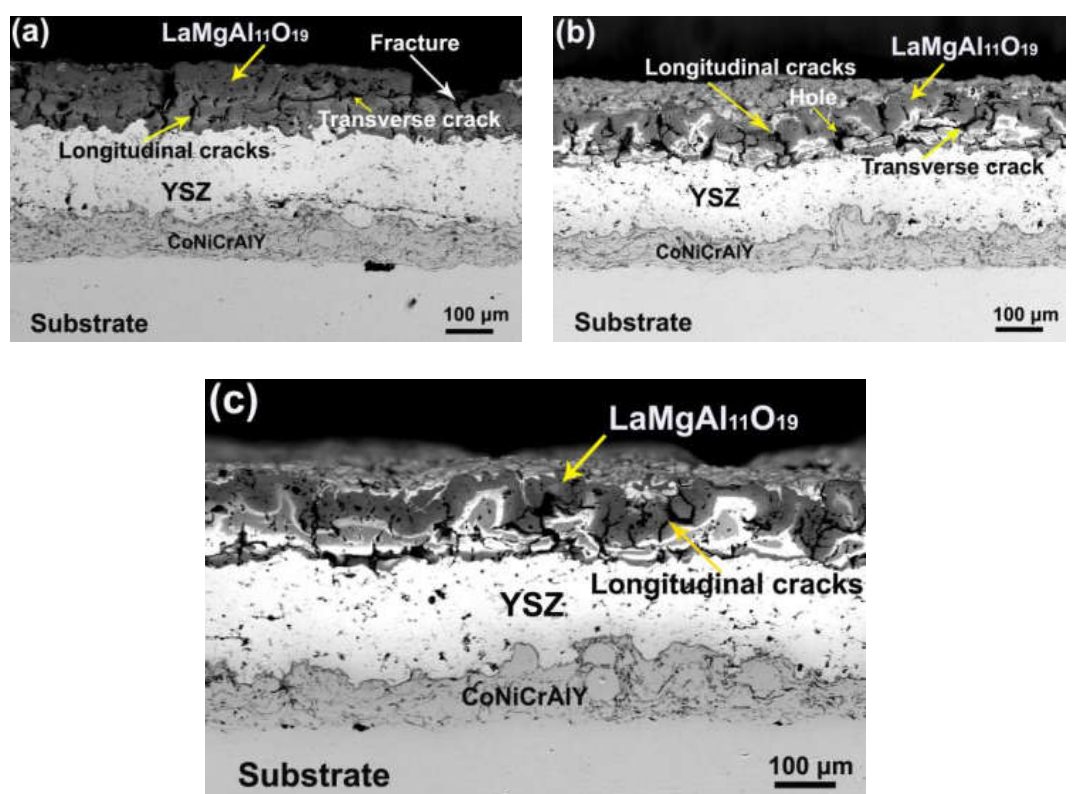
Figure 5. Cross-sectional SEM images of coatings after 6 h corrosion test: ( a ) S0, ( b ) S1, and ( c ) S2.